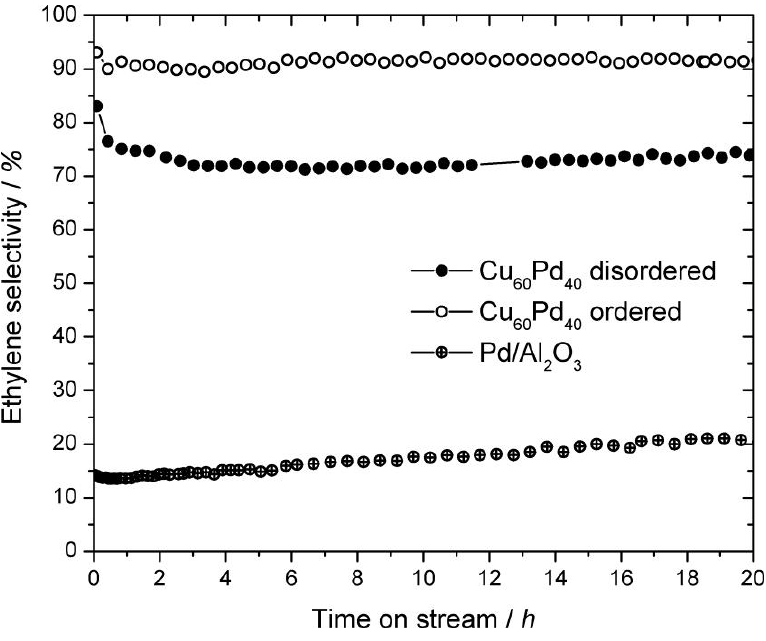
Figure 8. Selectivity to ethylene of ordered and disordered Cu and 5% Pd/Al O (0.5 mg) in the semi-hydrogenation of acetylene at 200 °C 2 3 (C H :H :C H = 1:10:100). The catalysts were tested without any pretreatments. The 2 2 2 2 4 experimental error lies within the radii of the depicted